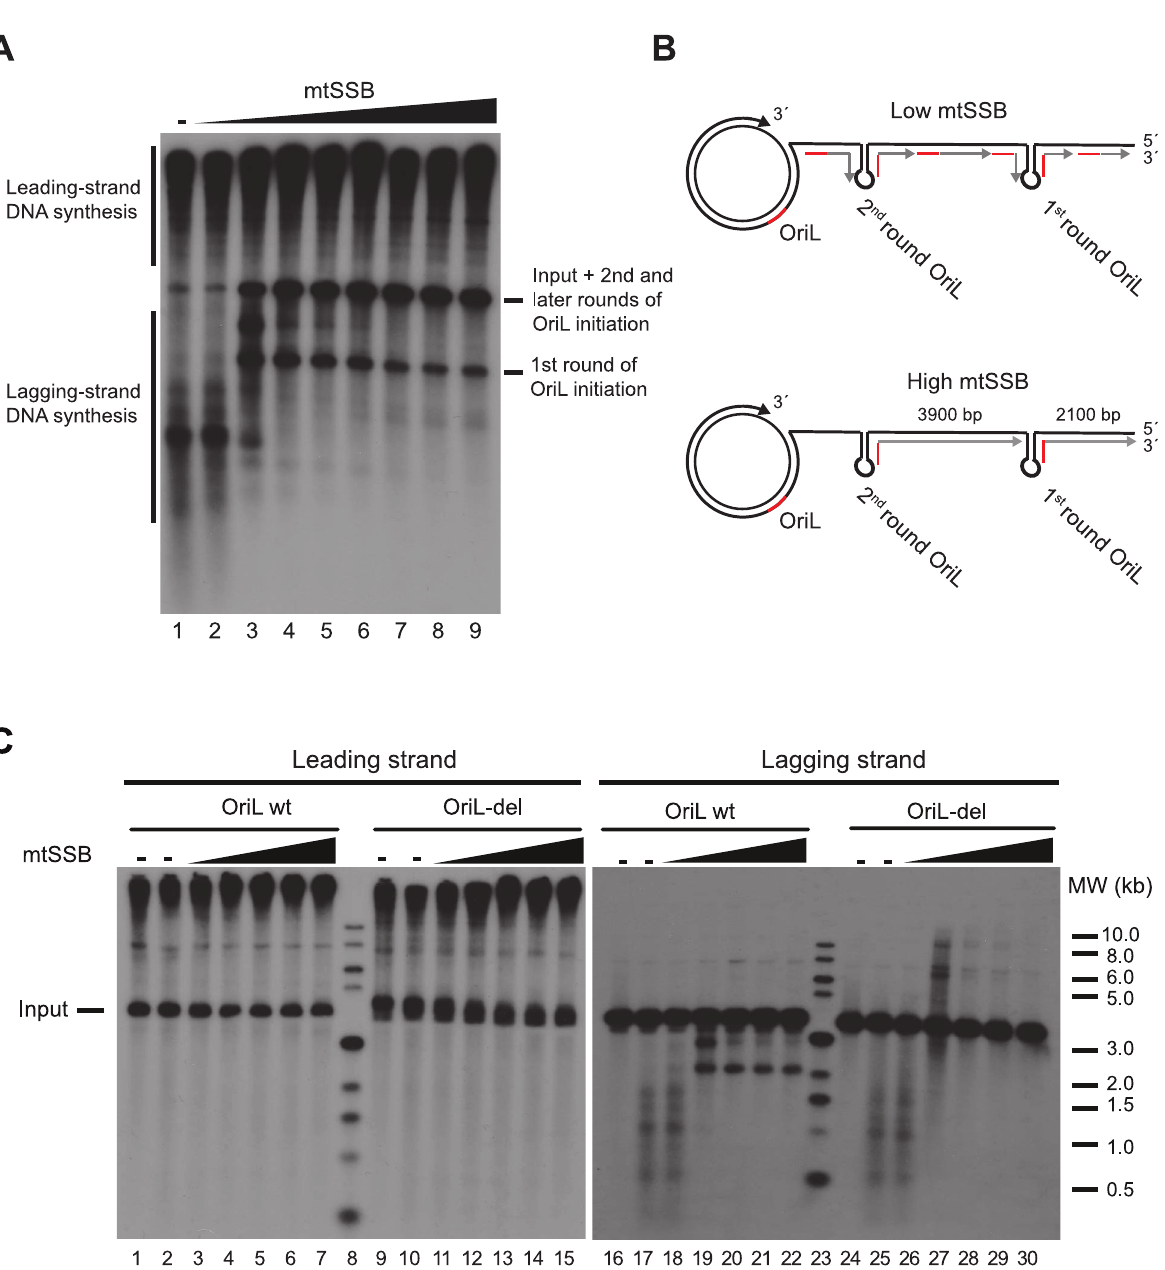
Figure 2. mtSSB governs OriL specificity. ( A ) In vitro rolling circle DNA replication reaction with increasing concentrations of mtSSB (0, 10, 100, 500 fmol, 1, 5, 10, 20 and 40 pmol) on the SK + OriL dsDNA template. DNA replication was performed in the presence of [ a - 32P]-dCTP in order to label newly synthesized DNA as described previously [6]. The weak labeling of input template in lanes 1 and 2 is most likely due to POL c idling on the free 3 9 -end, in the absence of active rolling circle DNA replication. ( B ) Schematic illustration explaining the replication products formed on lagging-strand DNA. At higher mtSSB levels, primers synthesis is restricted to OriL, but at lower levels primer synthesis can take place also at other sites. During the first round of DNA synthesis, the OriL-depending lagging-strand products have a length of about 2100 nts. In later rounds, the fragments will span the entire distance between two OriL sequences (about 3900 nts) and migrate with the same size as the input template. ( C ) Reactions were performed as in panel A, but replication products were analyzed by Southern blotting using strand-specific probes to detect leading- or lagging- strand DNA synthesis. For comparison, we used a mutant template (OriL-del) in which the OriL sequence had been deleted.